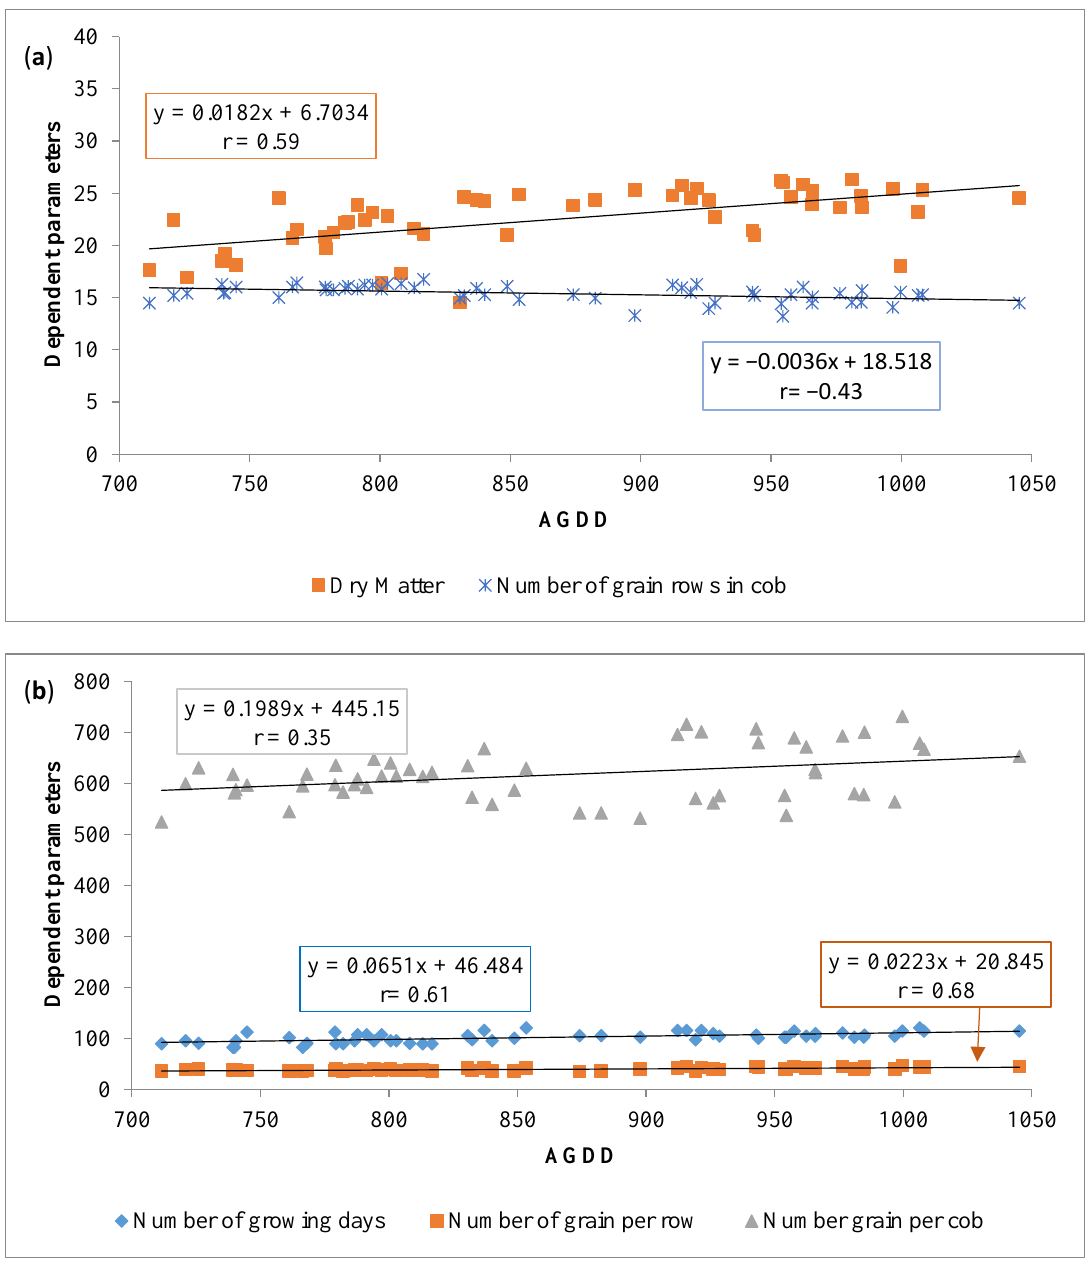
Figure 2. Effect of thermal condition presented in accumulated growing degree days of the sweet maize growing period and cob parameters. ( a ): Accumulated growing degree days (AGDD) vs. dry matter (DM), Number of grain rows in cob. ( b ): AGDD vs. number of growing days, number of grain per row, Number grain per cob.